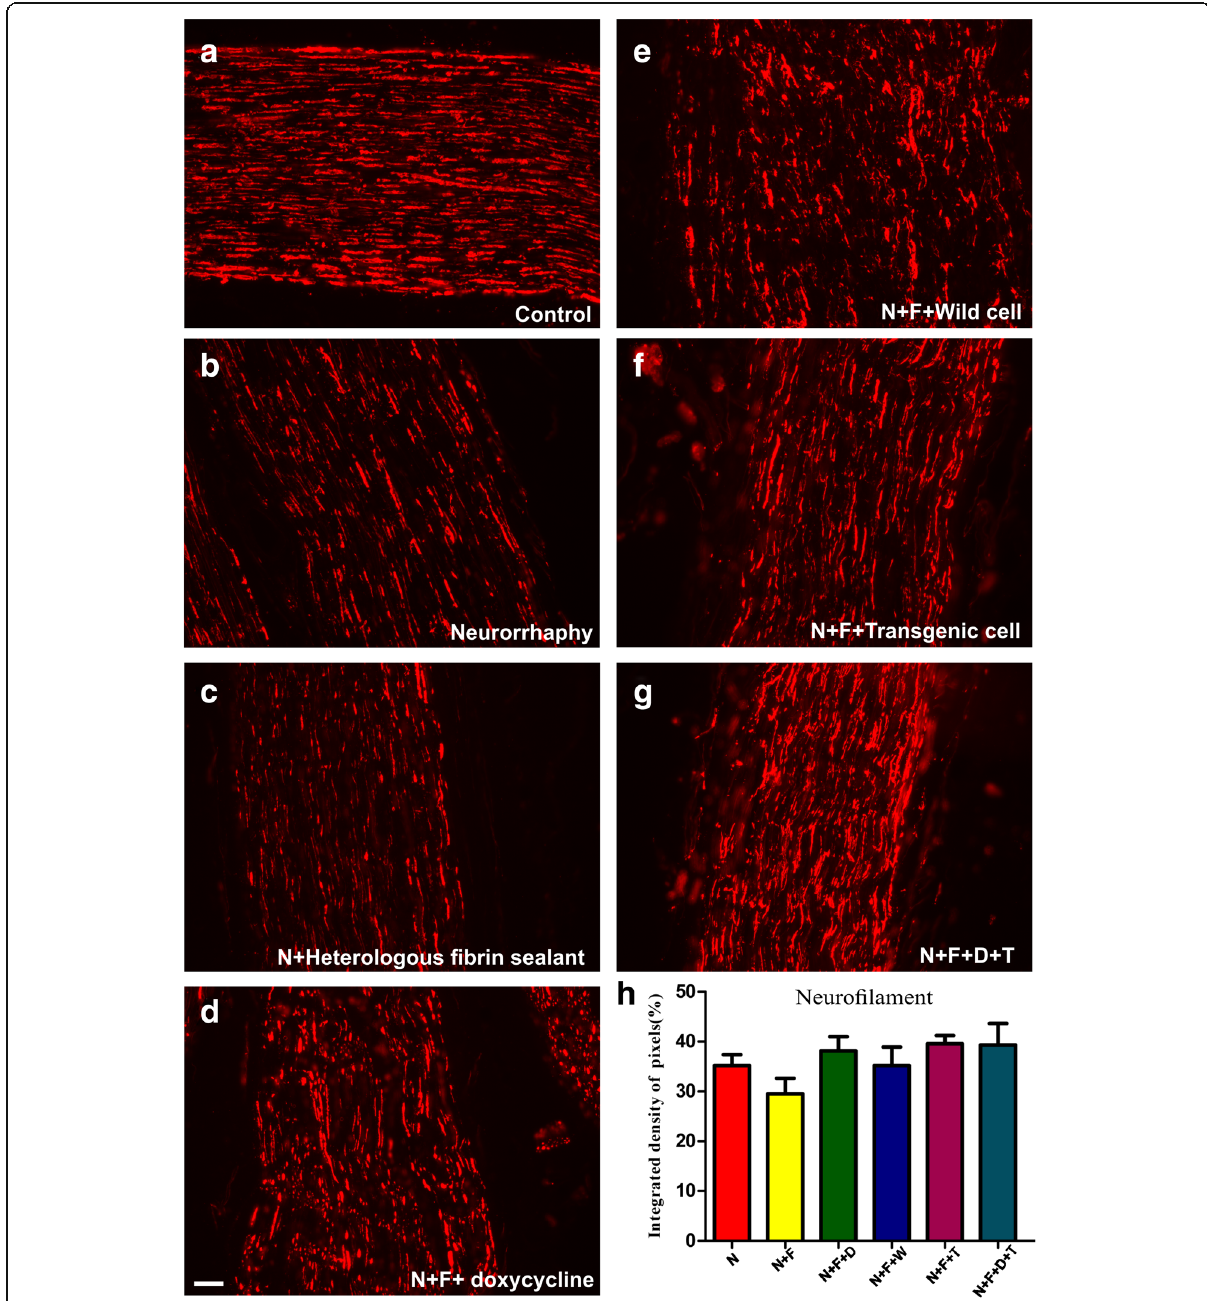
Fig. 3 Anti-neurofilament immunostaining of ( a ) the control nerves ( b to g ) and all groups, 60 days after surgery. h Quantification of the integrated density of pixels in the experimental groups relative to the control group presented in percentage (%) and calculated using Image J software. Statistically, there is no significant difference among the experimental groups. Scale bar: 50 μ m. N: neurorrhaphy, F: heterologous fibrin sealant, D: doxycycline, T: transgenic